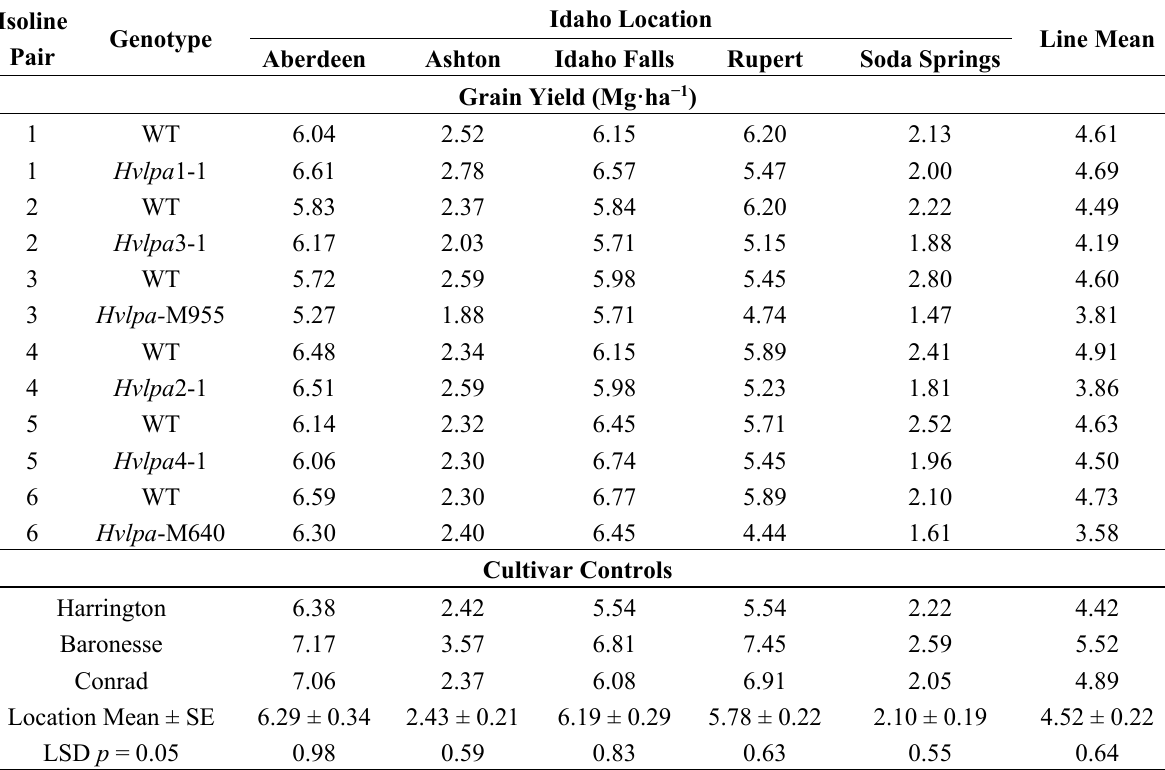
Table 3. Yield of barley lpa near-isogenic lines and three cultivar controls when grown in five locations in Idaho, 2010. Data represent means of four replicates at each location.